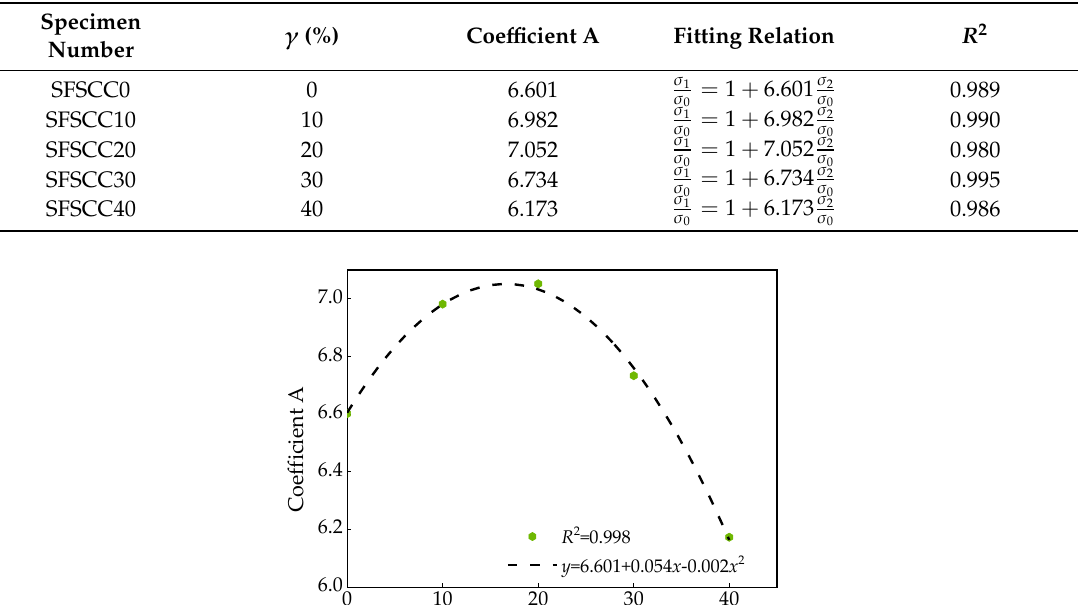
Table 8. Fitting relationship of SCC.